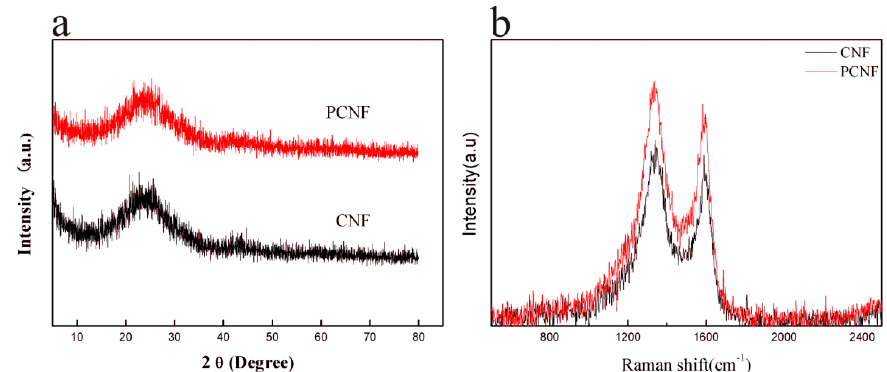
Figure 2. The XRD and Raman images of CNF (black) and PCNF (red) samples: (a) XRD pattern; (b) Raman pattern.